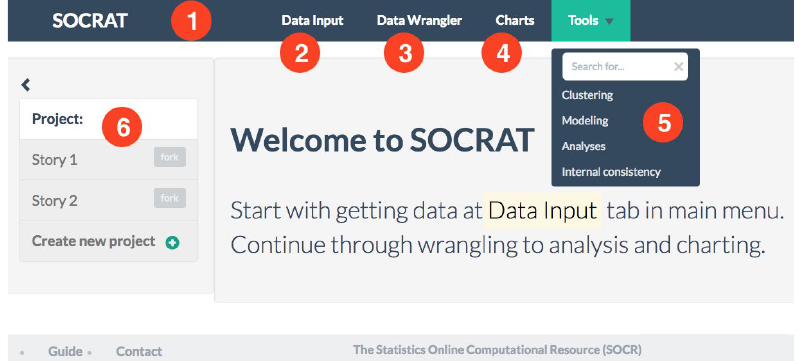
Figure 1. SOCRAT UI implementing an example of a high-level general VA workflow: ( 1 ) Main menu, automatically generated from the declarative configuration with active modules, including ( 2 ) Data Input module for loading and entering data; ( 3 ) Data Wrangler module for cleaning and transforming raw data; ( 4 ) Charts module for creating interactive visualizations; ( 5 ) Tools sub-menu for visually supported data analyses, including clustering, modeling and analytical tools; ( 6 ) Project management capability that will allow take snapshots of data, save visualizations and report analysis